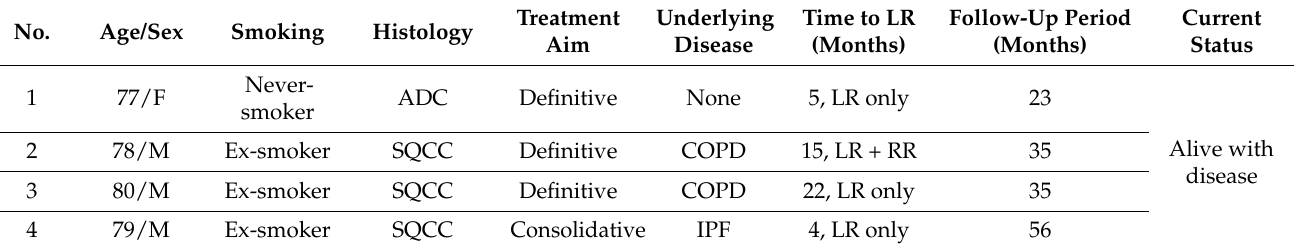
Table 2. Clinical courses of patients who showed local recurrence after